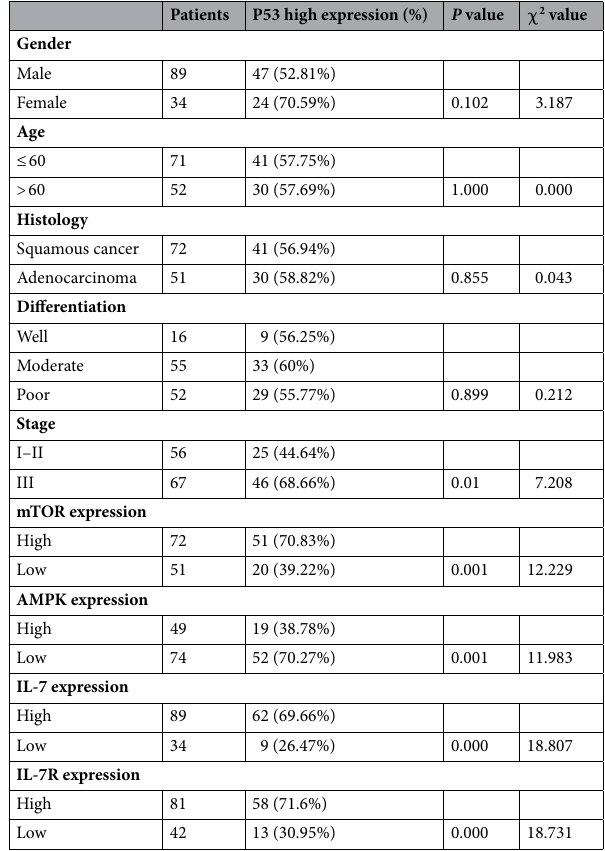
Table 2. Relationship between P53 expression in NSCLC and clinical pathological factors (Chi-square test).